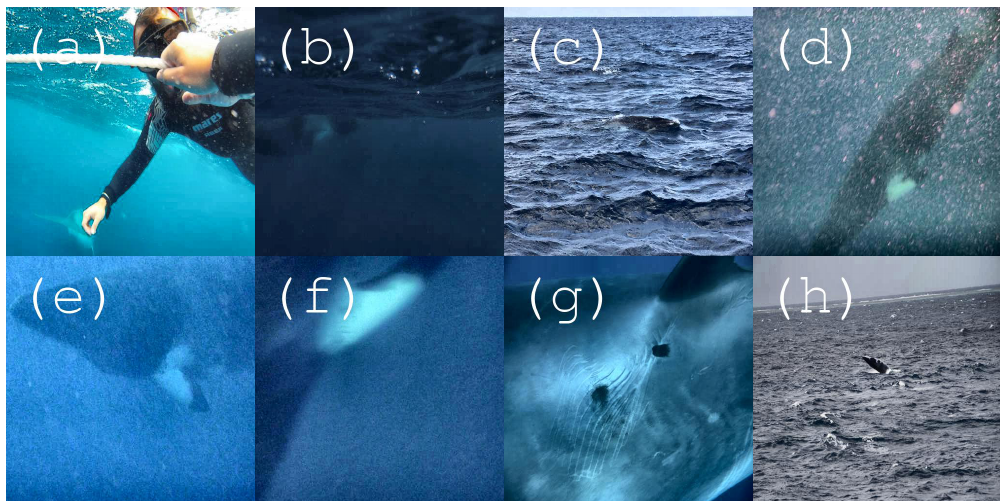
Figure 2. Sub-figures: ( a – h ) are examples of false-negative classification errors, which were the positive test images incorrectly predicted as negatives (missing whale) by Minke Whale Detector